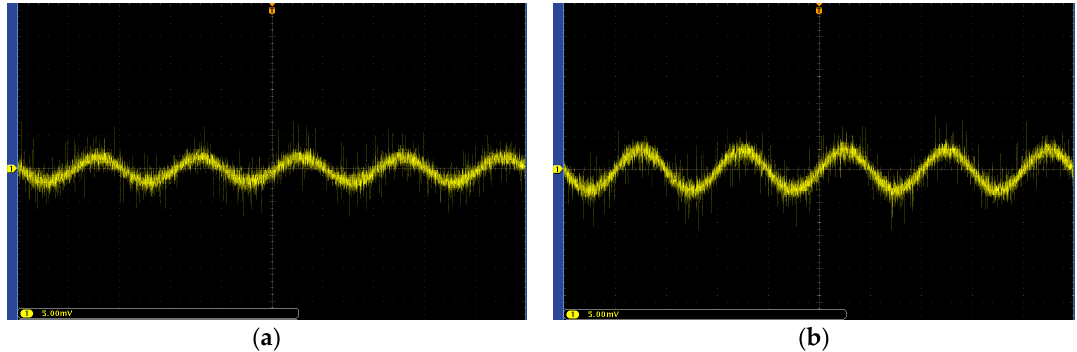
Figure 6. Waveform change diagram: ( a ) electric field strength is 0–31.3 V/m; ( b ) the electric field strength is 62.5 V/m.